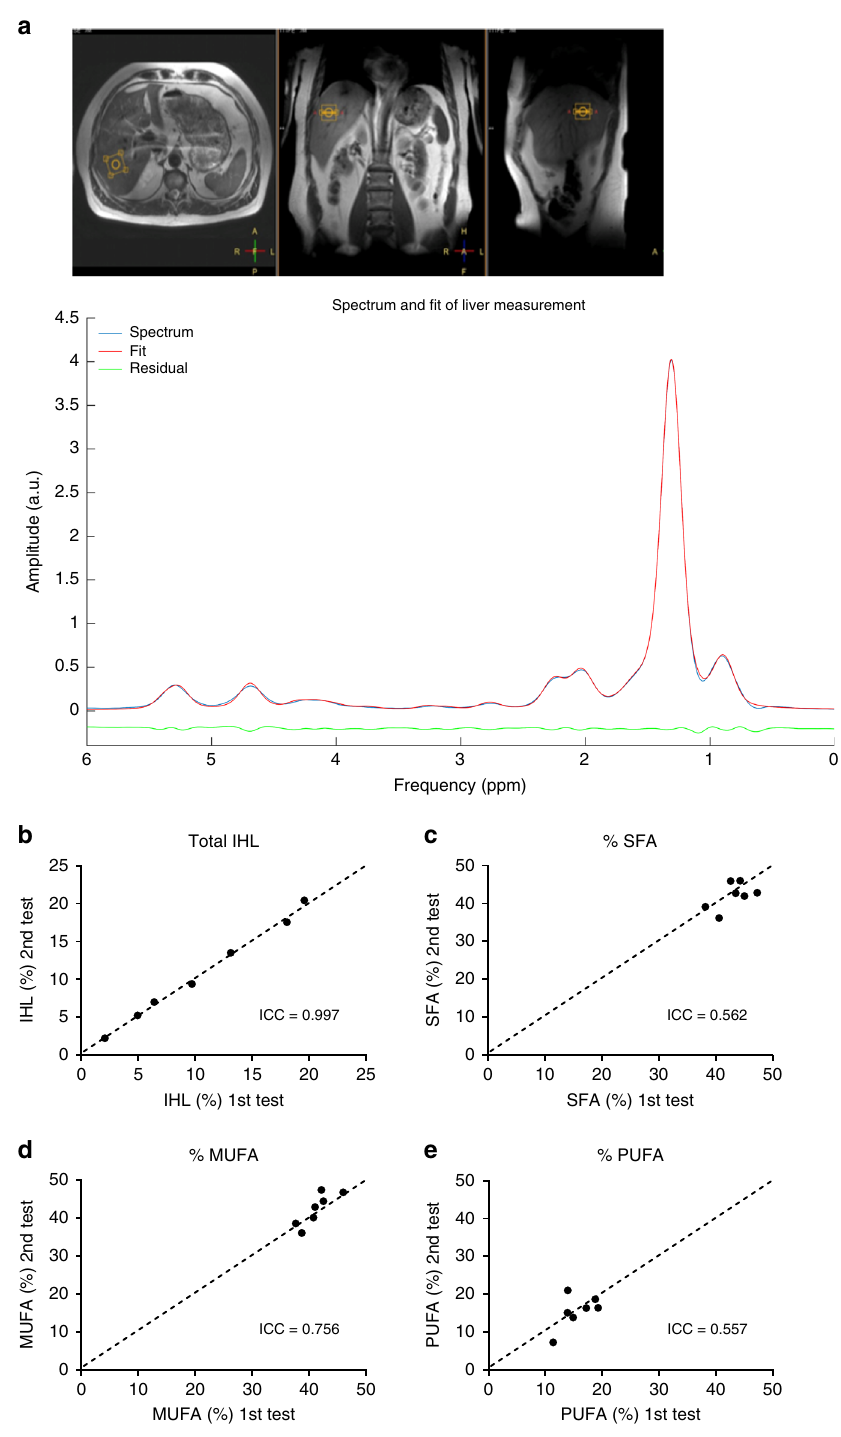
Fig. 3 Validation of 1 H-MRS method by testing reproducibility in vivo. a T2 weighted Turbo spin echo MR image showing the voxel position located on liver and its corresponding lipid spectrum together with the fi tted spectrum. Scatter plots showing the reproducibility of b total liver fat content and c SFA fraction, d MUFA fraction, and e PUFA fraction ( n = 7). Reproducibility was tested by performing two repeated measurements. The intraclass correlation coef fi cient (ICC) is shown in the respective plots (Intraclass